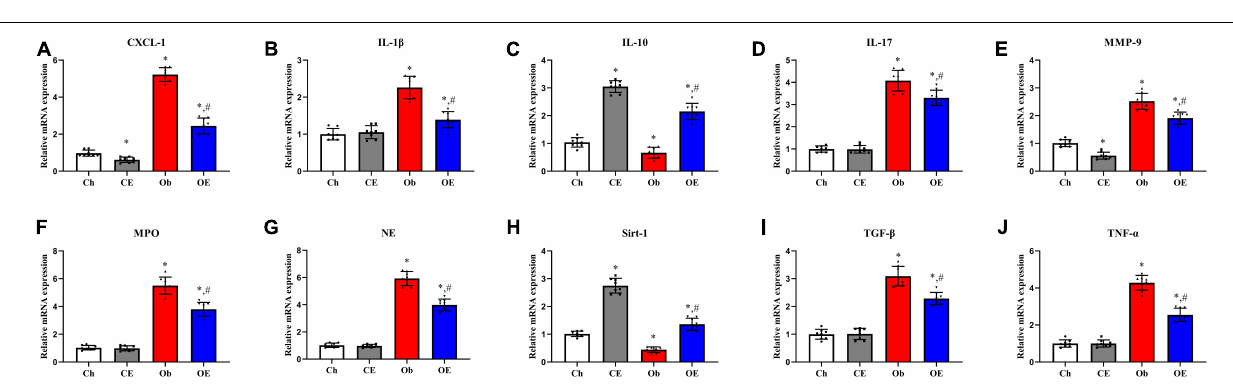
FIGURE 4 | Detection of mRNA expression levels in lung tissue. Detection of mRNA expression levels of CXCL-1 (A) , IL-1 β (B) , IL-10 (C) , IL-17 (D) , MMP-9 (E) , MPO (F) , NE (G) , sirt-1 (H) , TGF- β (I) , and TNF- α (J) in lung tissue. # P < 0.05 compared with the Ch group. ∗ P < 0.05 compared with the Ob group. CXCL, C-X-C motif chemokine ligand; IL, interleukin; MMP, matrix metalloproteinase; NE, neutrophil elastase; Sirt, sirtuin; TGF, transforming growth factor; TNF, tumour necrosis